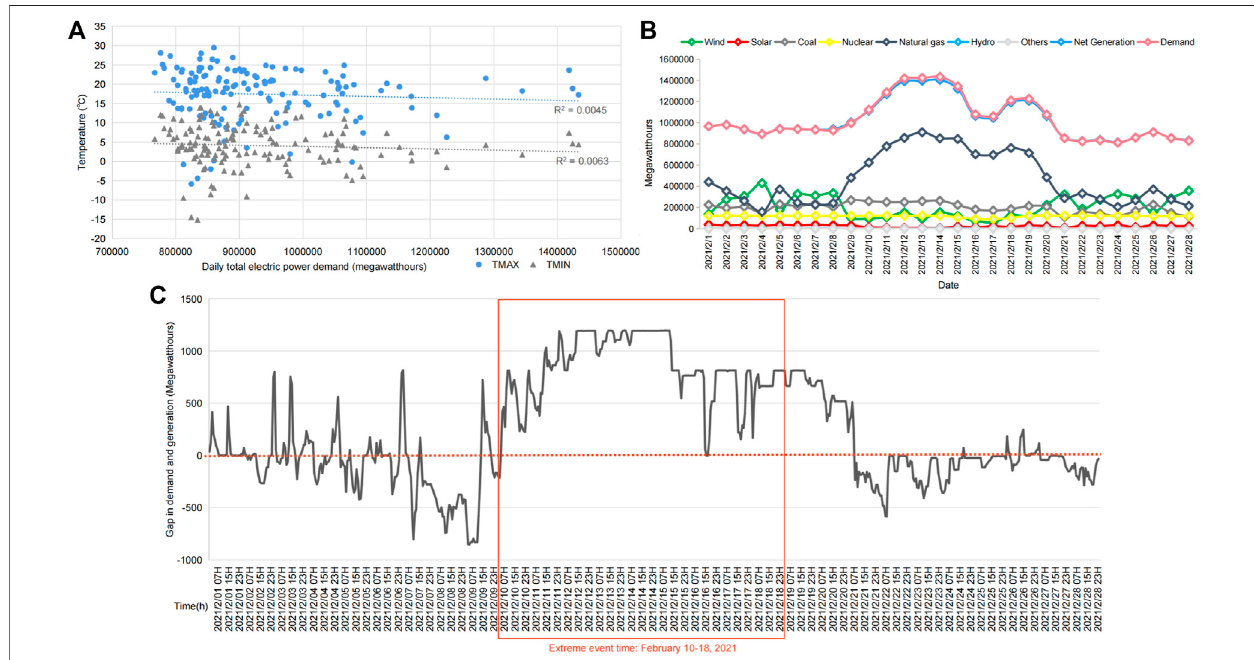
FIGURE 6 | (A) Relationship between daily electric power demand and temperature in February in Texas from 2017 to 2021; (B) demand and net generation by energy source for Texas in February 2021; and (C) gap between demand and net generation in February 2021.